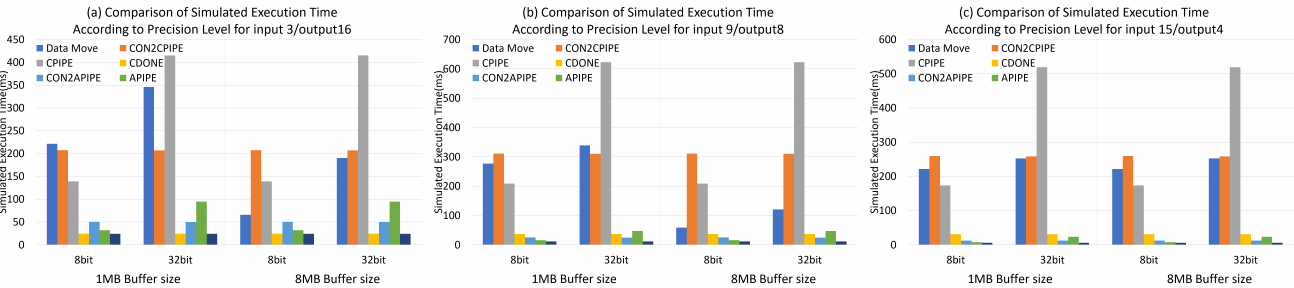
Figure 11. It shows the simulated excution time in each sub-module by performing convolution and maxpooling oper- ations of 3 NN operations according to the precision level with 1 M and 8 M buffers, respectively; ( a ) input3/output16, ( b ) input9/output8, ( c ) input15/output4.